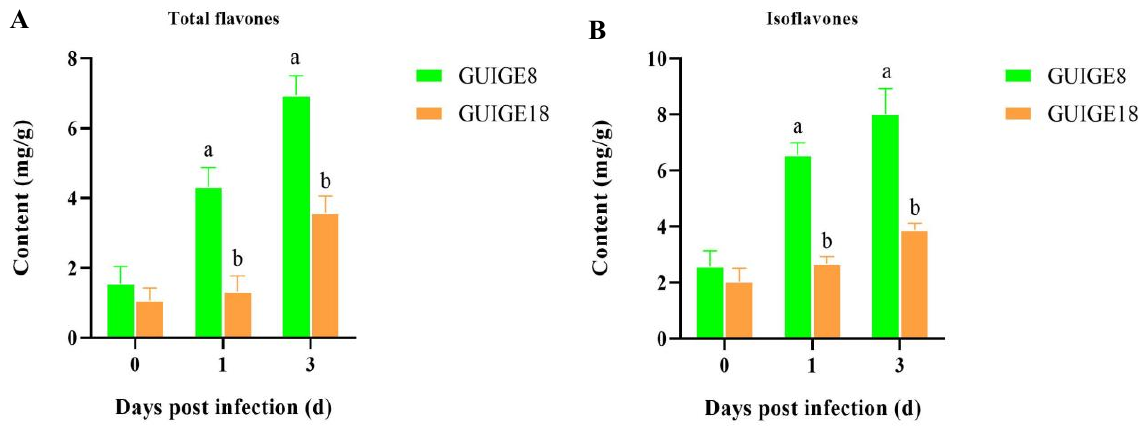
Figure 10. The flavonoid content across three time points (0, 1, and 3 days) after SpM infection in resistant (GUIGE18) and susceptible cultivars (GUIGE8). ( A ) Total flavone content; ( B ) isoflavone content. Letter ‘a/b’ indicate differences change between the two cultivars on the same day ( p < 0.05), according to Duncan’s multiple range test using SPSS software.